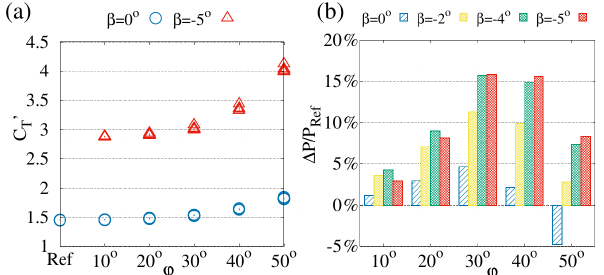
Figure 5. Effect of the tilt angle ϕ on (a) the local thrust coefficients C (cid:48) of upwind-row turbines when they are operated with β = 0 ◦ T (default axial induction) or with β = − 5 ◦ (strongly overinductive regime), (b) the total power gain ( P − P Ref ) /P Ref for selected val- ues of β